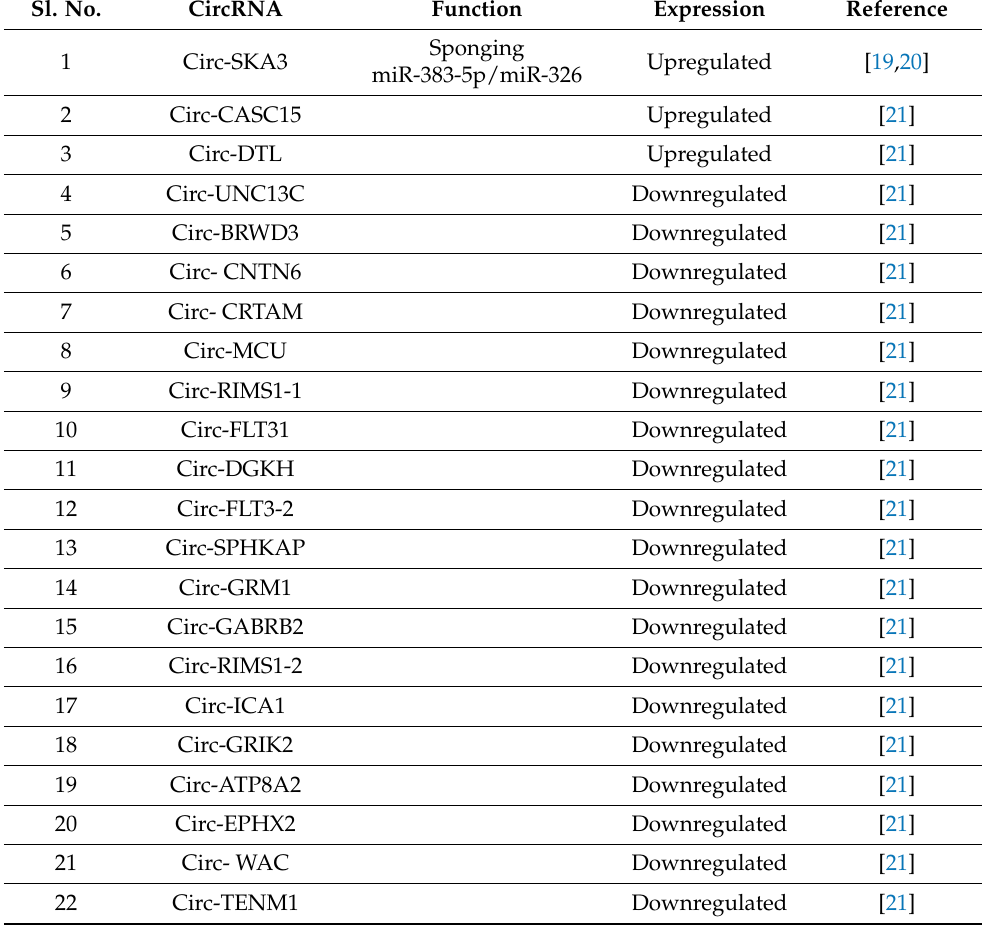
Table 1. List of circRNAs responsible for the down-regulation and up-regulation of medulloblastoma. Sl. No. CircRNA Function Expression